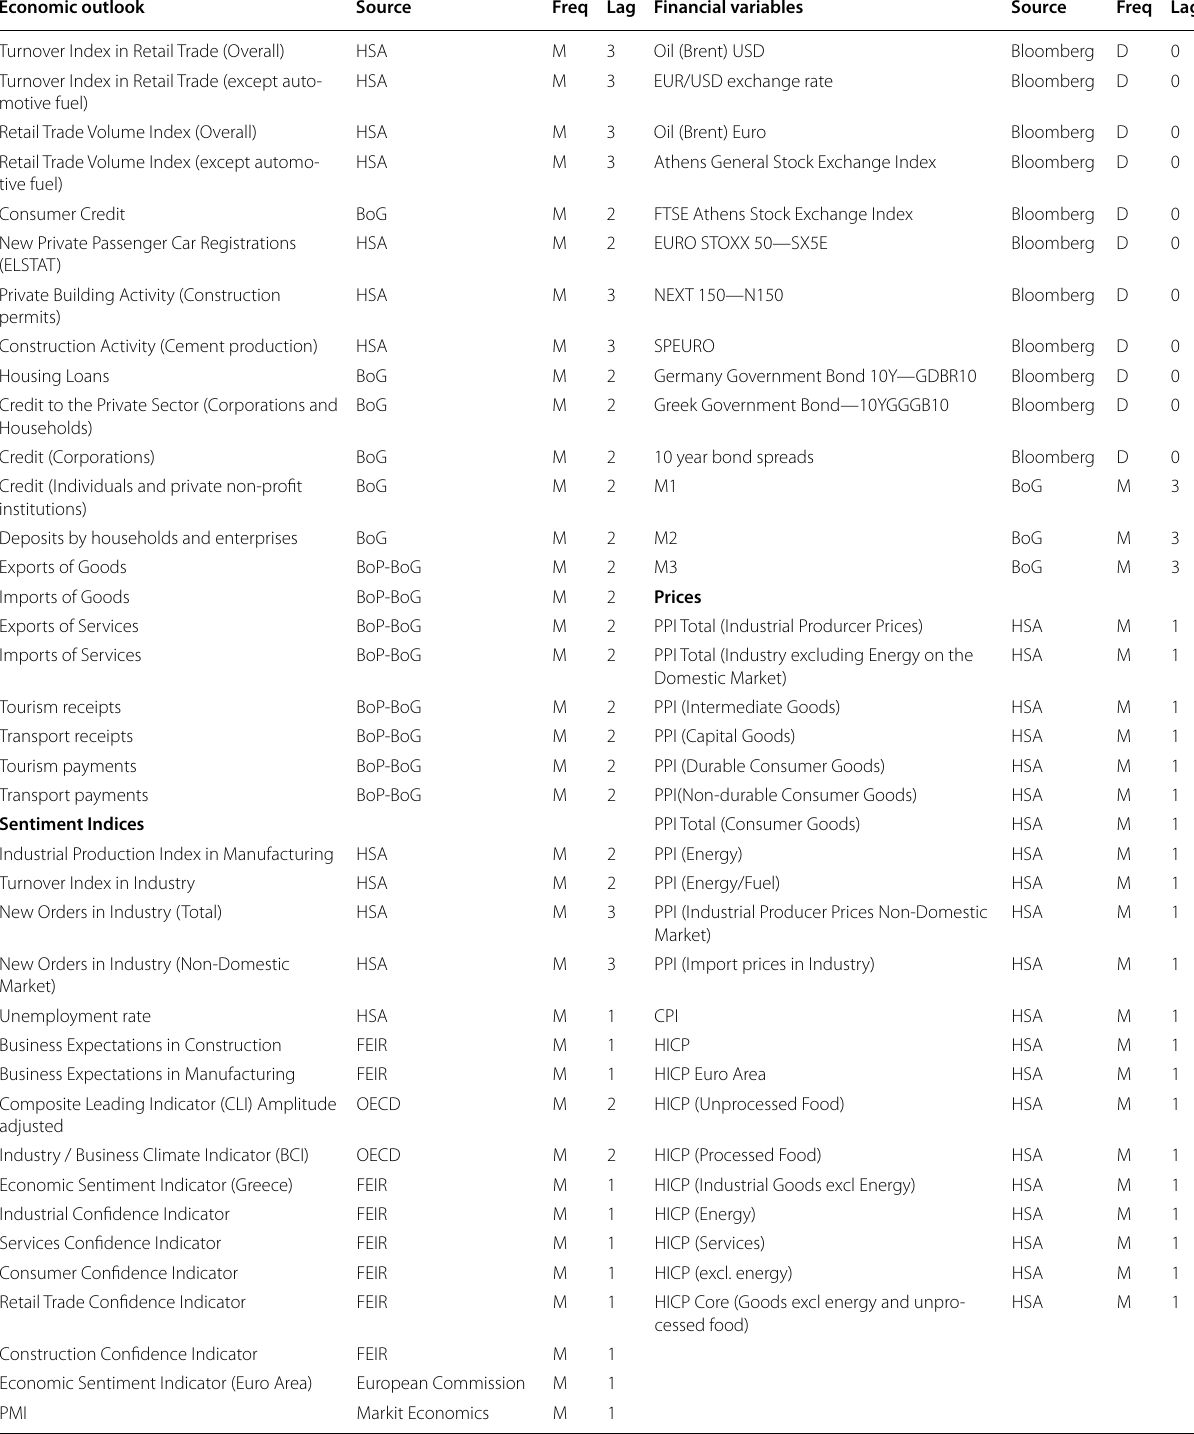
Table 1 Explanatory variables under